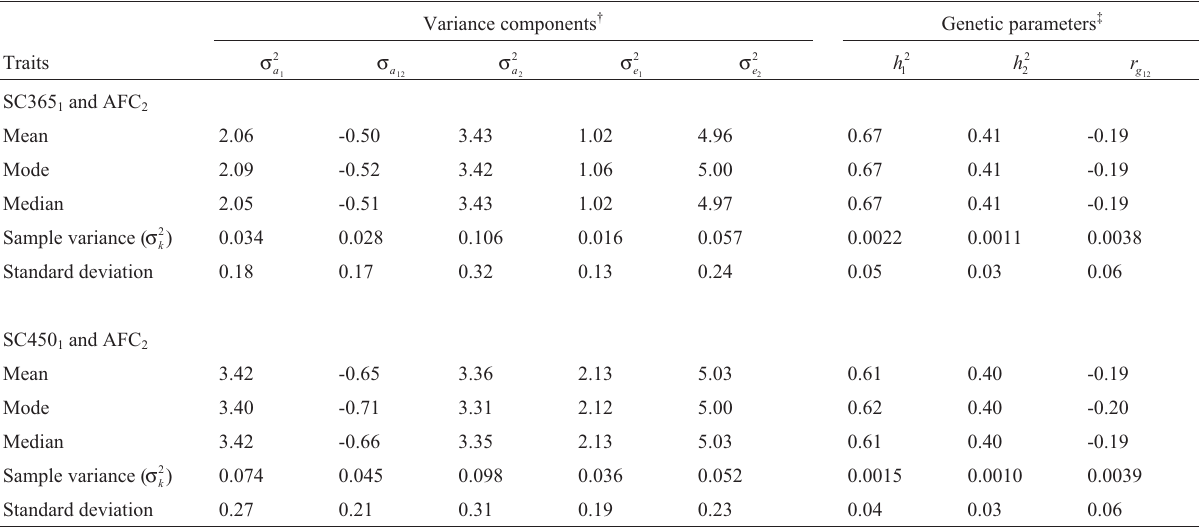
Table 3 - Descriptive statistics for variance components and genetic parameters for age at first calving (AFC) and scrotal circumference at 365 (SC365) and 450 (SC450) days based on two-trait analyses using Gibbs Sampling. Variance components † Genetic parameters ‡ Traits